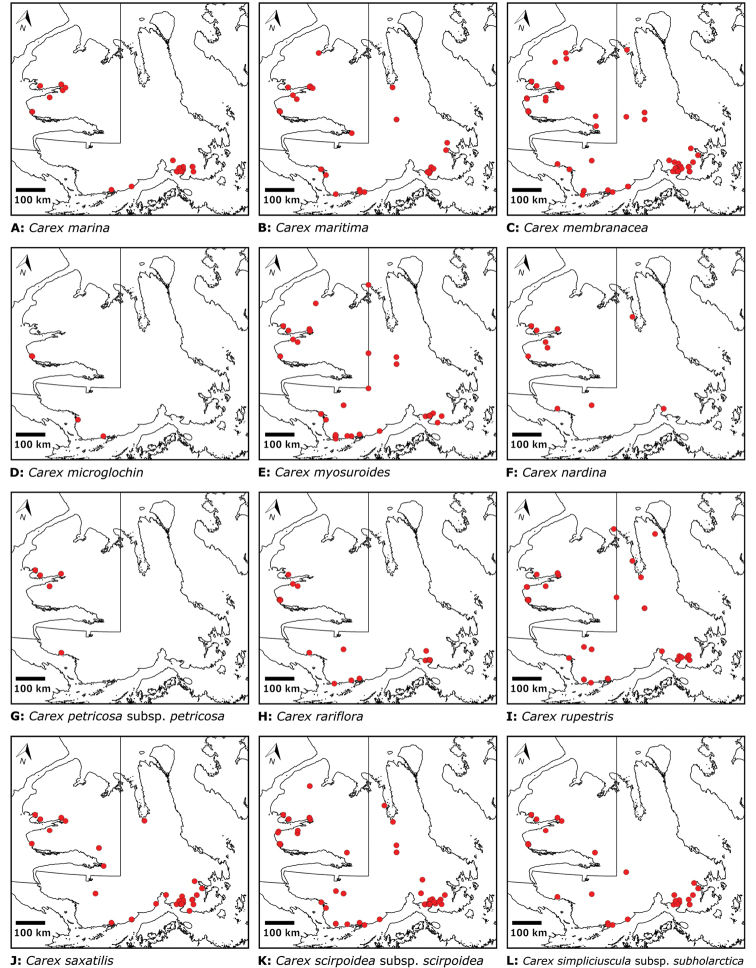
Species distribution maps. Cyperaceae: ACarex
marinaBCarex
maritimaCCarex
membranaceaDCarex
microglochinECarex
myosuroidesFCarex
nardinaGCarex
petricosa
subsp.
petricosaHCarex
rarifloraICarex
rupestrisJCarex
saxatilisKCarex
scirpoidea
subsp.
scirpoideaLCarex
simpliciuscula
subsp.
subholarctica.